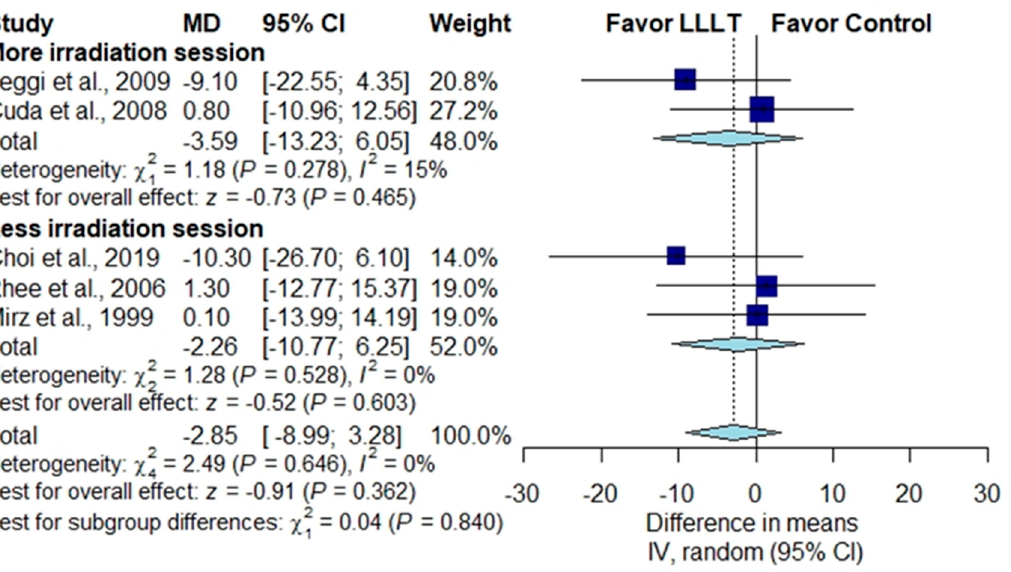
Figure 6. Subgroup analysis of THI scores according to the number of irradiation sessions [1,28–31] .